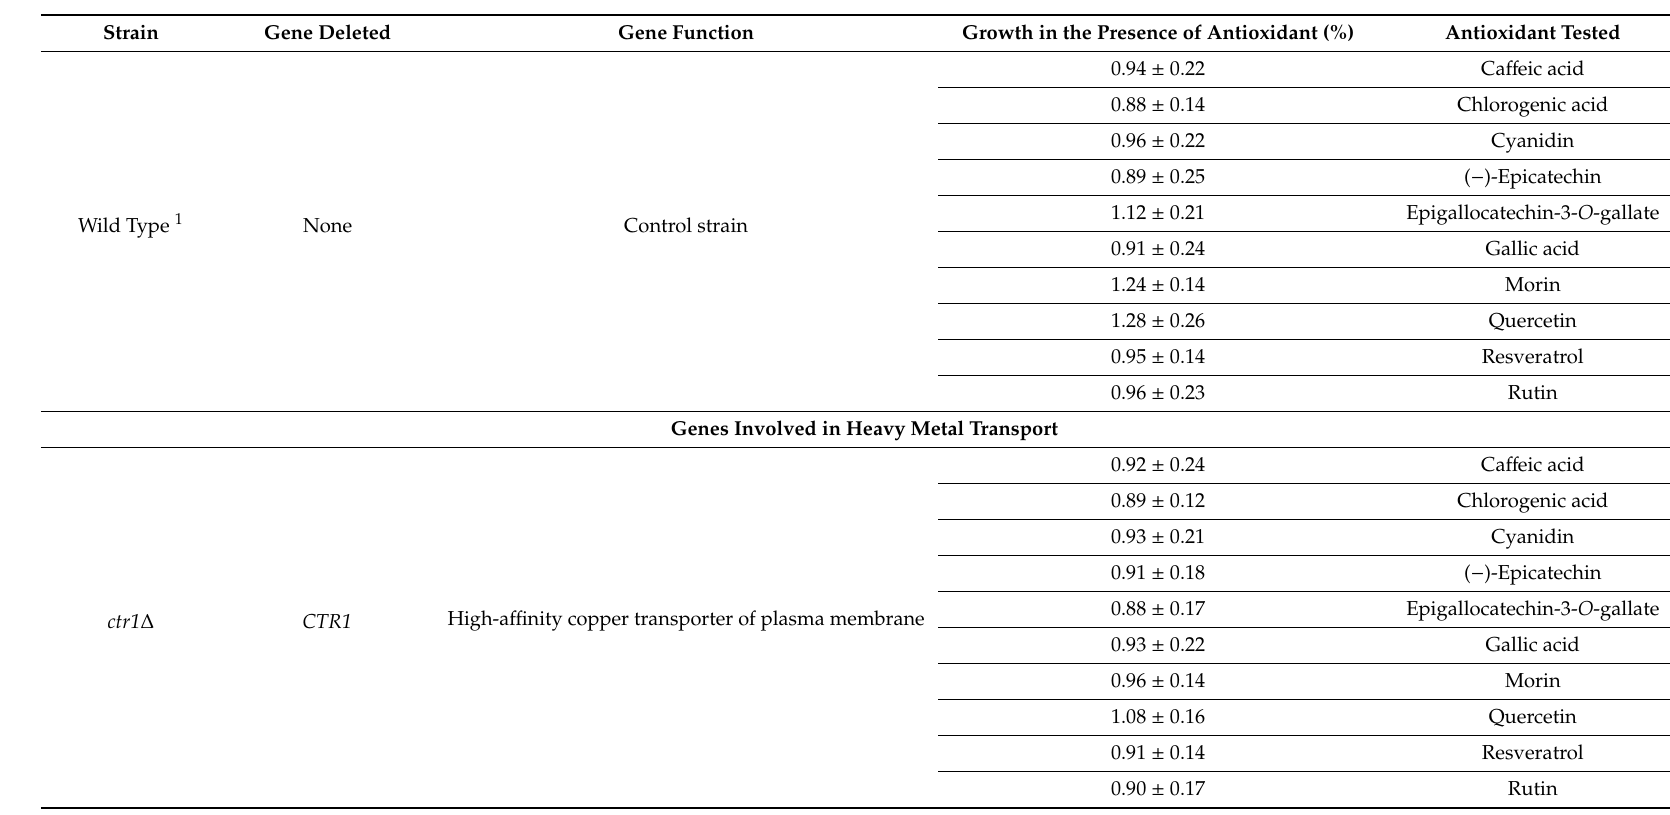
assessed spectrophotometrically (OD 660 ) after 16 h of incubation with shaking (200 rpm at 30 ◦ C) and expressed as the ratio between cell densities in the presence and in the absence of the corresponding polyphenol. Results are mean ± standard error of the mean (SEM) of three independent determinations. The combination strain / polyphenol that determined improved growth by at least 25% (bold, *) or growth inhibition by at least 25% (bold, # ) were selected for further